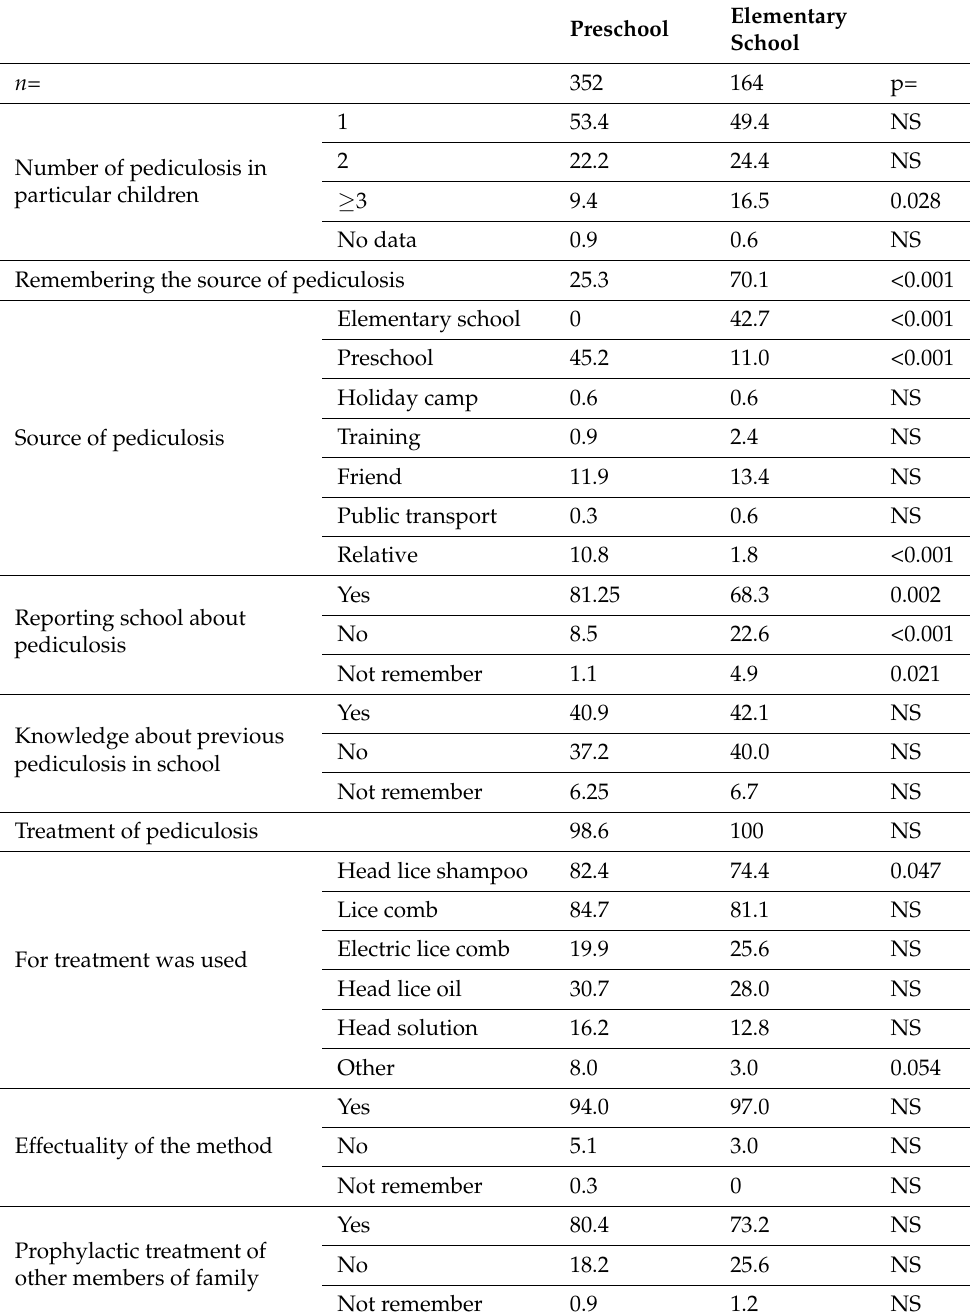
Table 3. Sources and management for lice in families with a history of